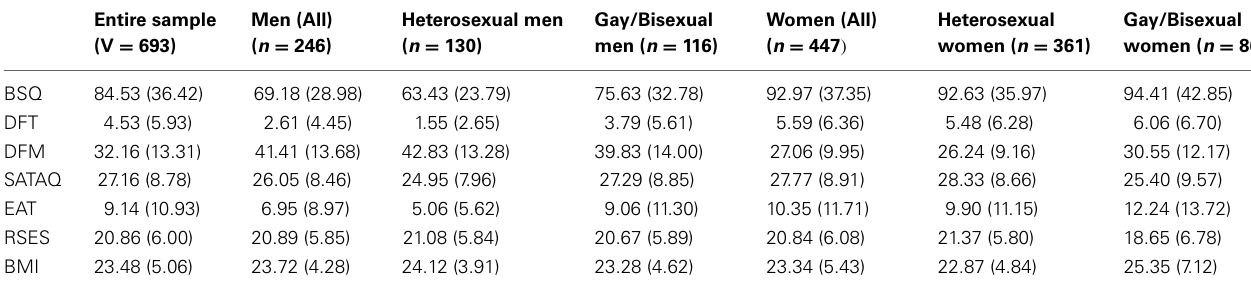
Table 1 | Descriptive statistics for each variable of interest. Entire